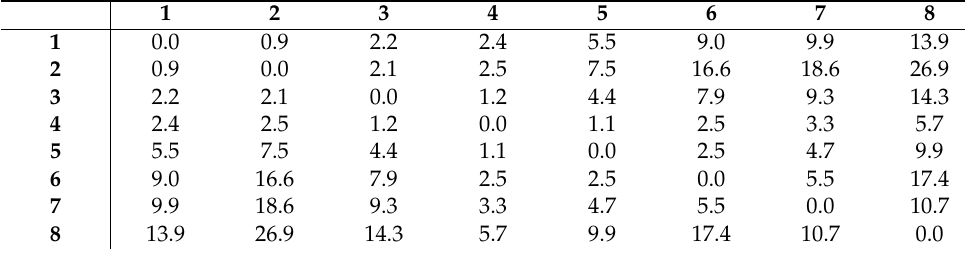
Table 3. Effort matrix E 2 for route two.